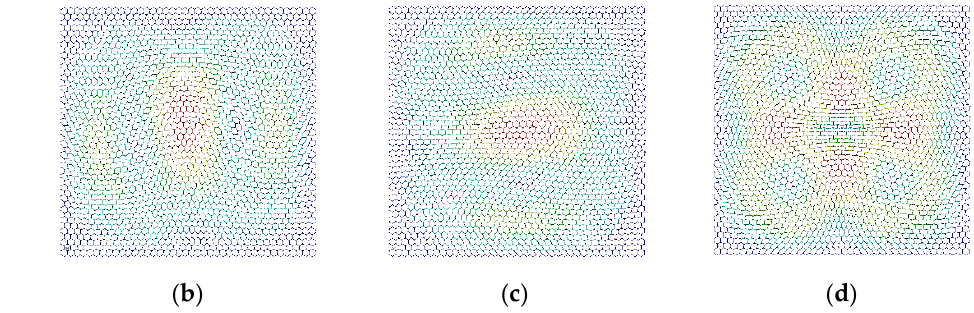
Figure 11. The vibration modes of graphene with the width of the carbon covalent bonds equal to 0.005 nm (( a – d ) represent the first four resonant vibration modes).